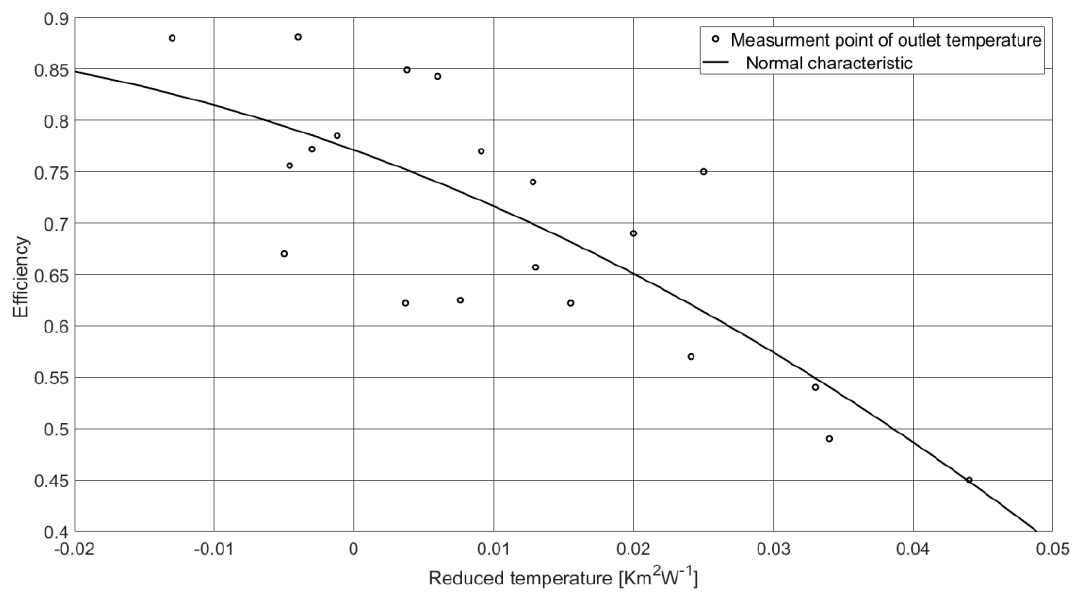
Figure 8. Collector e ffi ciency characteristics determined according to the ISO 9806 standard under outdoor conditions.